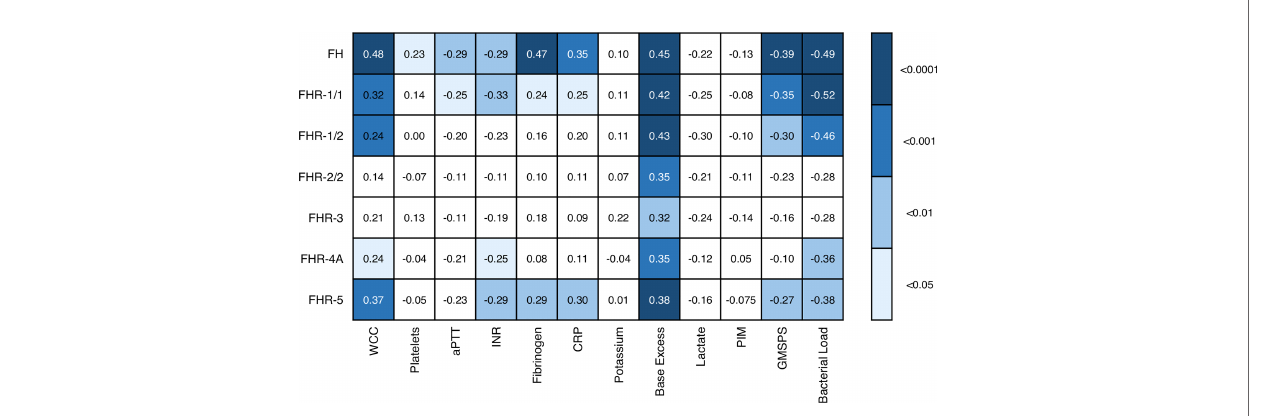
FIGURE 4 | Associations of acute stage FH family protein levels with clinical and laboratory parameters. Pearson correlation coef fi cients ( r ), considering twelve severity markers and seven FH family proteins (including the different dimers). Correlations were assessed using Pearson ’ s measure of association, followed by the Benjamini-Hochberg procedure to control for the false discovery rate (FDR, set to 0.05). Blue shades indicate, from light to dark: p < 0.05; p < 0.01; p < 0.001; and p < 0.0001. WCC, white cell count; aPTT, activated partial thromboplastin time; INR, international normalized ratio; CRP, C-reactive protein; PIM, pediatric index of mortality; GMSPS, Glasgow Meningococcal Septicemia Prognostic Score.